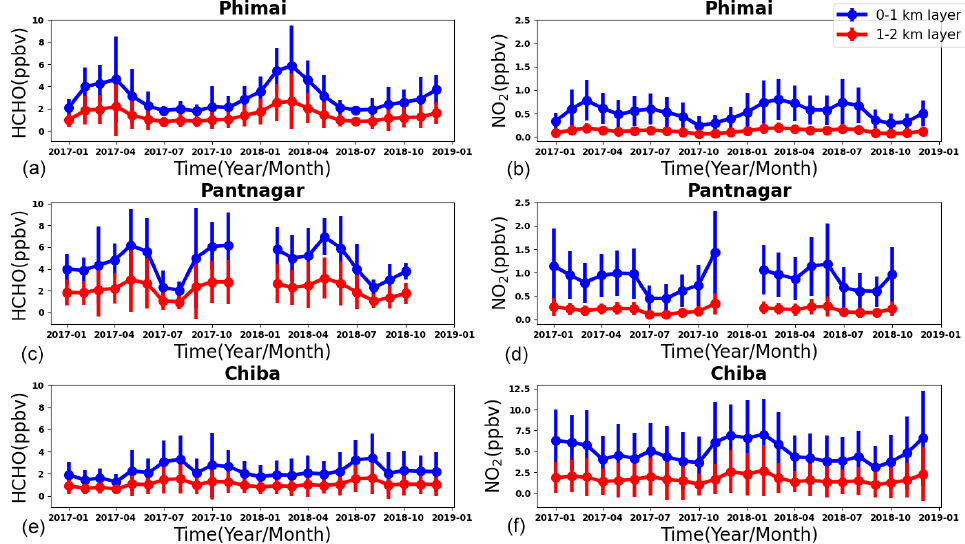
Figure 4. Seasonal variations in the HCHO (a, c, e) and NO 2 (b, d, f) mixing ratios in the 0–1 (blue) and 1–2km (red) layers at Phimai, Pantnagar, and Chiba. The error bars represent the 1 σ standard deviation of the mean values. The gaps in the plots for the Pantnagar site indicate the unavailability of observations during the investigated